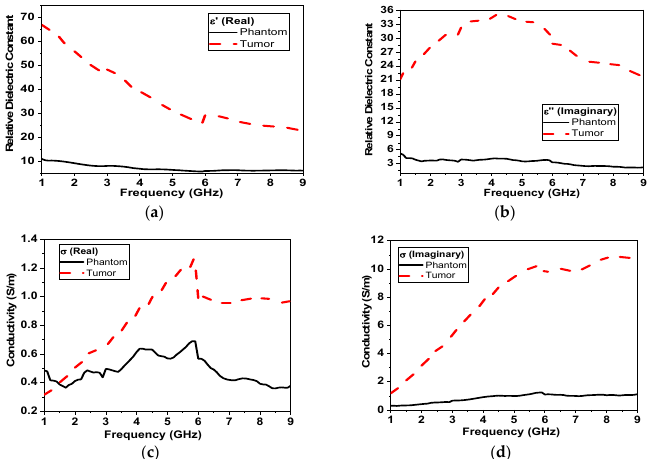
Figure 6, Measured electrical properties of breast phantom and tumor models versus frequency: ( a ) real part of dielectric constant ( ε′ ), ( b ) imaginary part of dielectric constant ( ε″ ), ( c ) conductivity ( σ ), and ( d ) imaginary part of conductivity ( σ ).